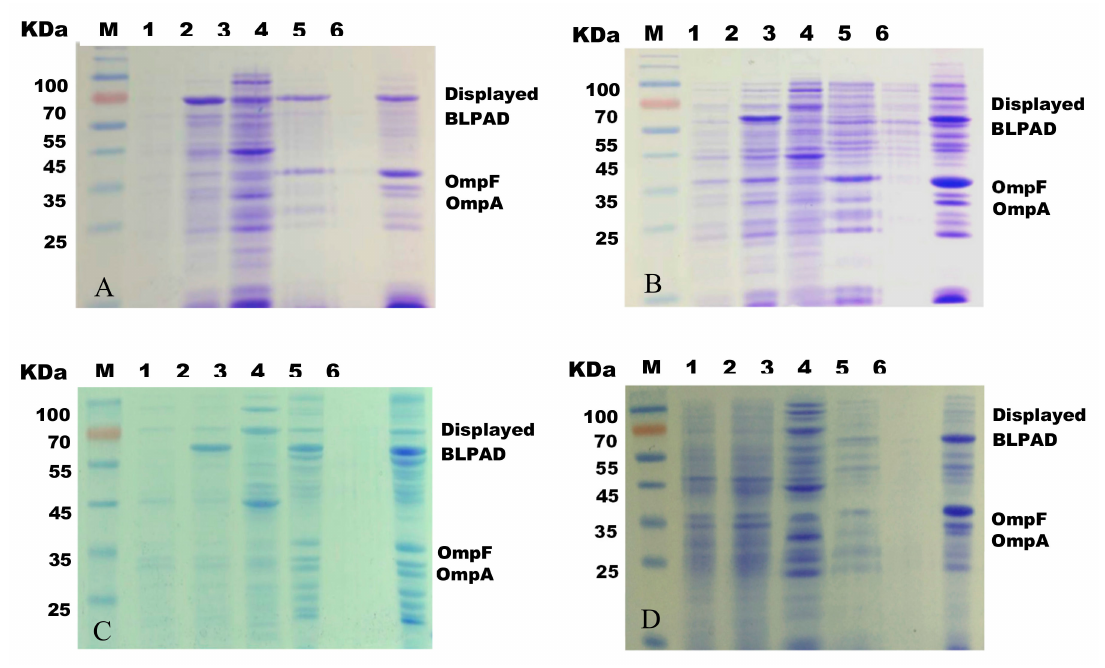
Figure 3. Expression and membrane localization of the surface-displayed cells. ( A , B ) BL21(DE3) cells and BL21 (DE3) pLysS cells carrying a pET22b-pelblpad vector. ( C , D ) BL21(DE3) cells and BL21 (DE3) pLysS cells carrying a pET22b-gdsllpad vector, respectively. M: protein marker; Lane 1–6: whole-cell lysates of no induced cell, whole-cell lysates of induced cell, soluble fraction, total membrane fraction, inner membrane fraction, and outer membrane fraction.